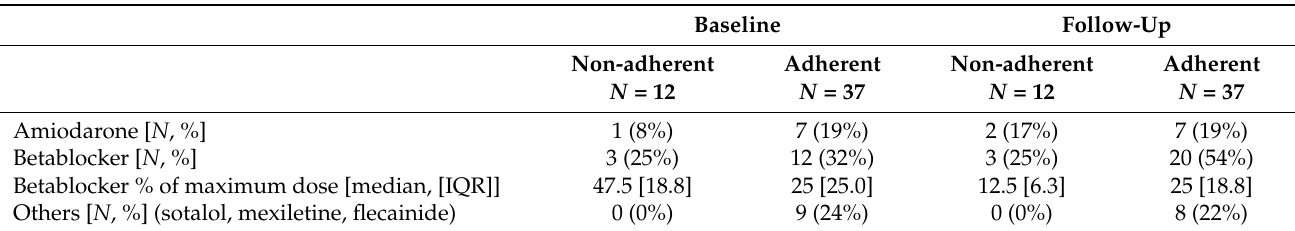
Table 2. Antiarrhythmic